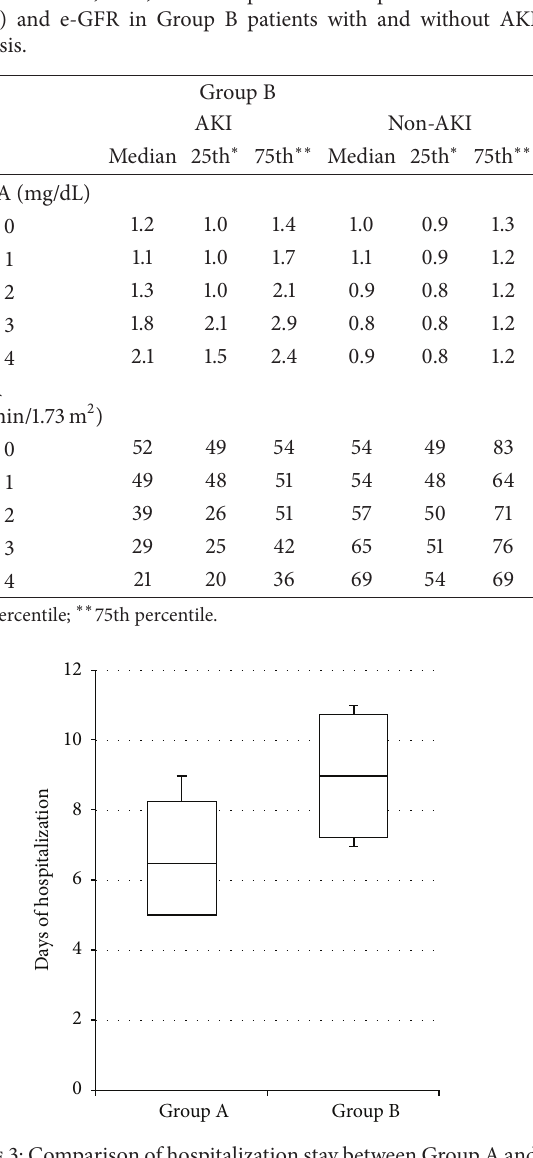
Figure 3: Comparison of hospitalization stay between Group A and Group B patients who developed